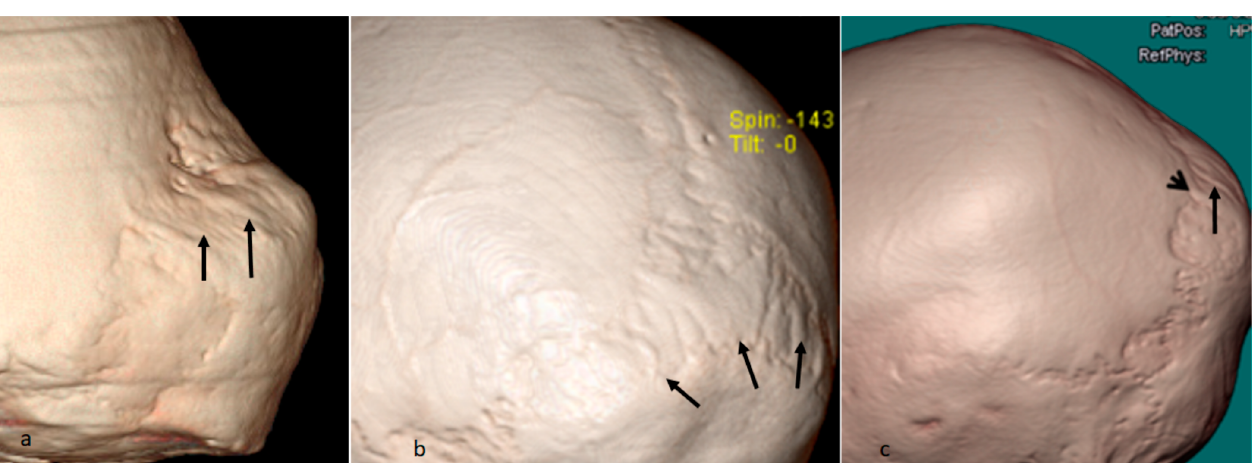
Figure 6. ( a – c ) We summarized the actual phenotype of the wormian bones via enlarging the 3D reconstruction CT scans of some of the aforementioned patients to illustrate clearly through 3D reconstruction CT scan of the lambdoid sutures a clearly delineation of the typical phenotype of wormian bones. All manifest an overly stretched pastry-like phenotype (arrows).